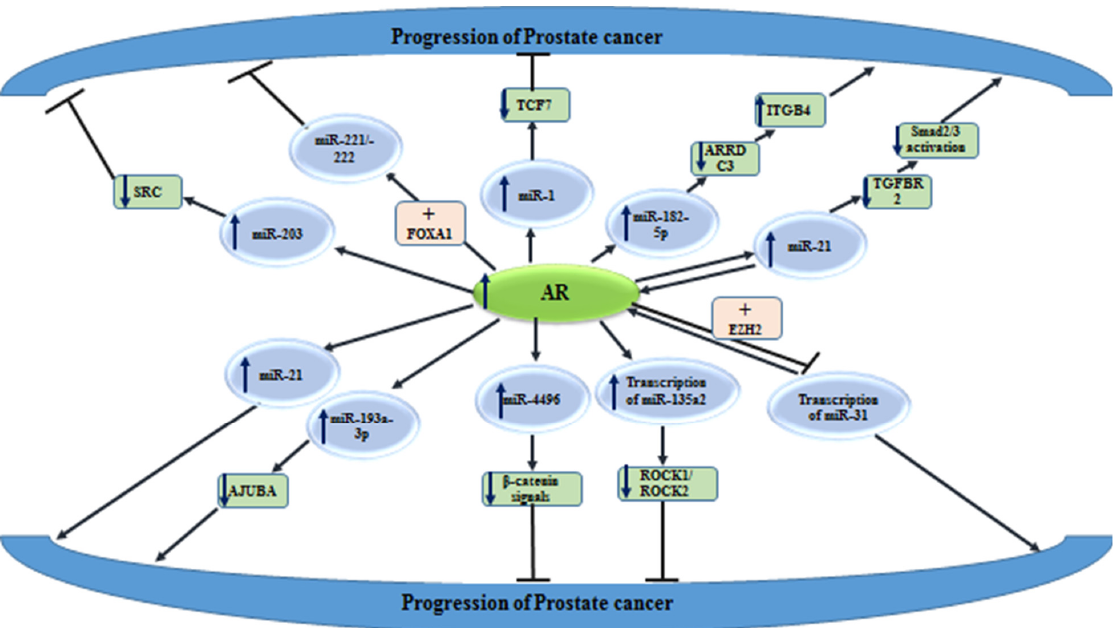
Figure 4. Effects of AR on miRNAs expressions, in the context of prostate cancer. Detailed information about these miRNAs is shown in Table 6 ( reduction or inhibition of, increased levels of, decreased levels of).